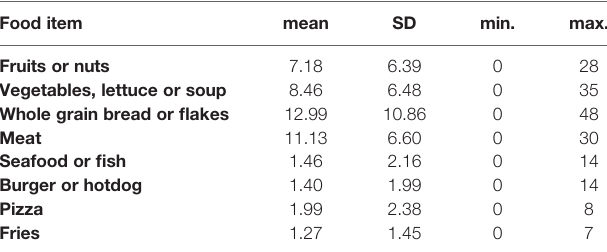
TABLE 3 | Descriptives of food items consumed by TIEGER participants in one week.